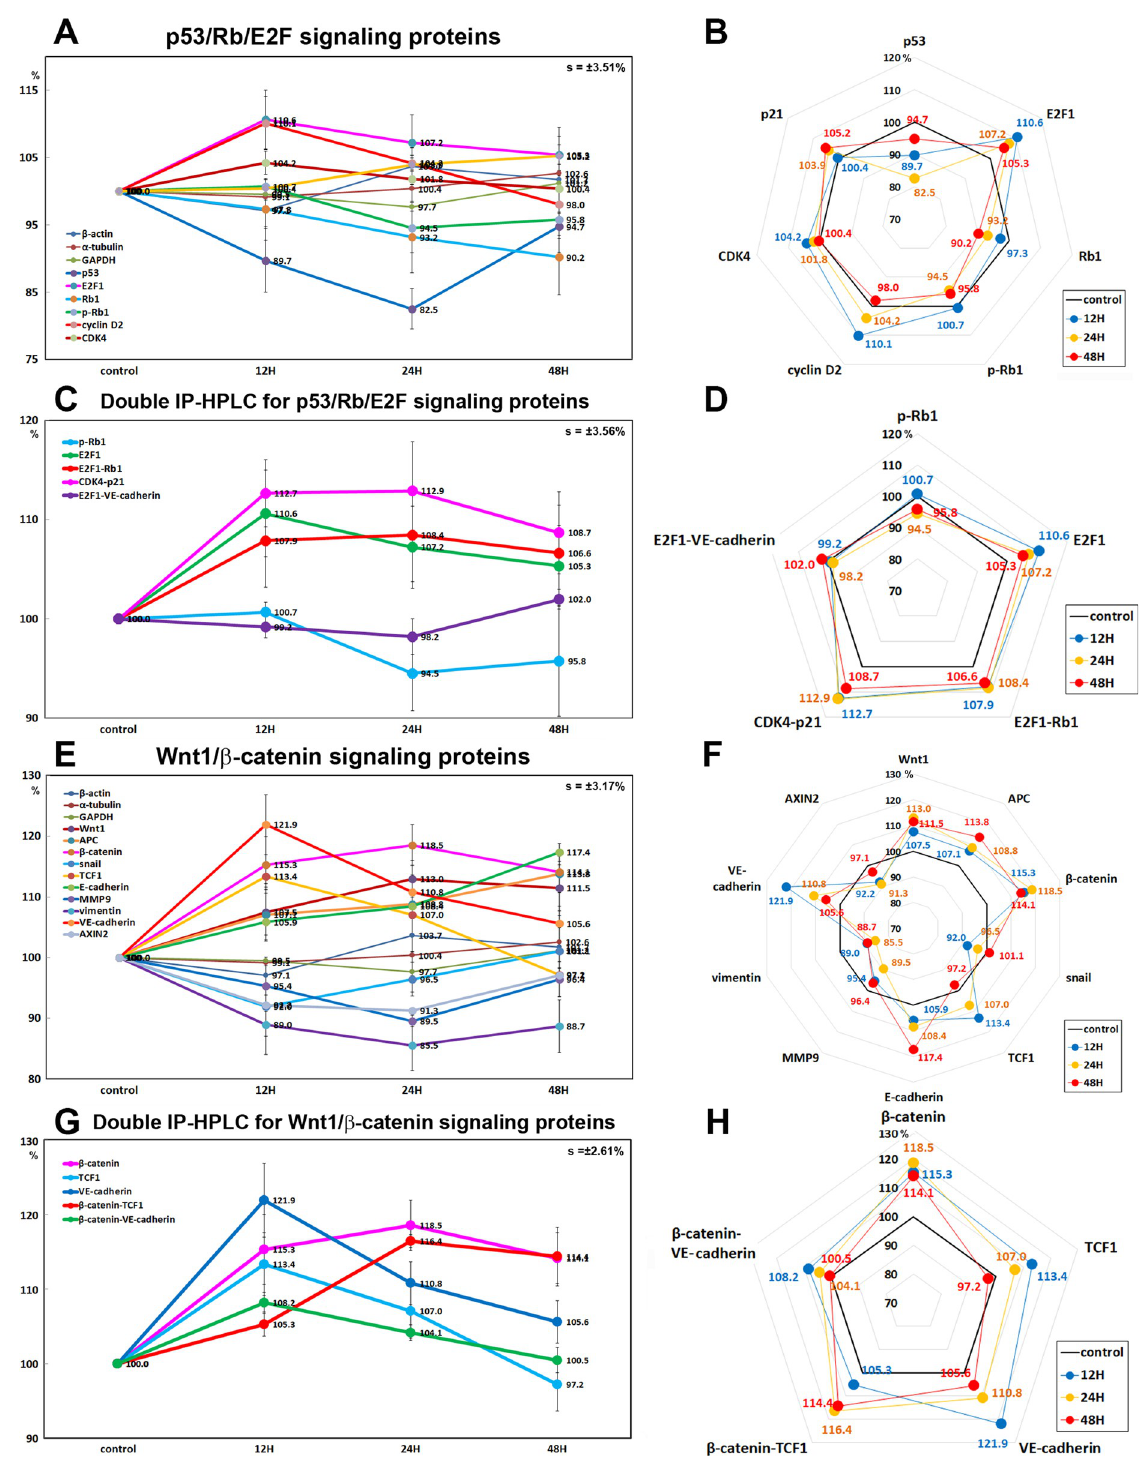
Fig 9. Expression of p53/Rb/E2F signaling proteins (A and B), double IP-HPLC for p53/Rb/E2F signaling protein complexes (C and D), Wnt/ β -catenin signaling proteins (E and F), and double IP-HPLC for Wnt/ β -catenin signaling protein complexes (G and H) in 10 μ g/mL PTX-treated RAW 264.7 cells as determined by IP-HPLC. Line graphs, A, C, and E show protein expression on the same scale (%) versus culture time (12, 24, or 48 h), whereas the star plots (B, D, and F) show the differential expression levels of the proteins at 12, 24, or 48 h after PTX treatment on the appropriate scales (%). The thick black line, untreated controls (100%); the blue, yellow, and red dots show differential protein levels after PTX administration for 12, 24, or 48 h, respectively. https://doi.org/10.1371/journal.pone.0261797.g009 PLOS ONE | https://doi.org/10.1371/journal.pone.0261797 March 25,